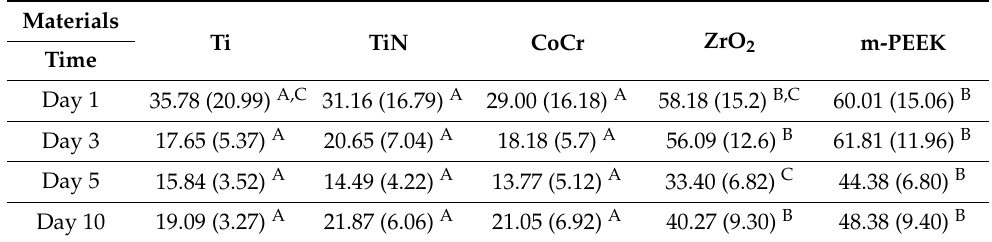
Table 3. The mean and standard deviation values of cell proliferation percentage at days 1, 3, 5, and 10 (HGFB). Values with the same superscript letters represents a non-significant difference (Tukey’s post hoc ( p > 0.05)) between the investigated materials at each time point.